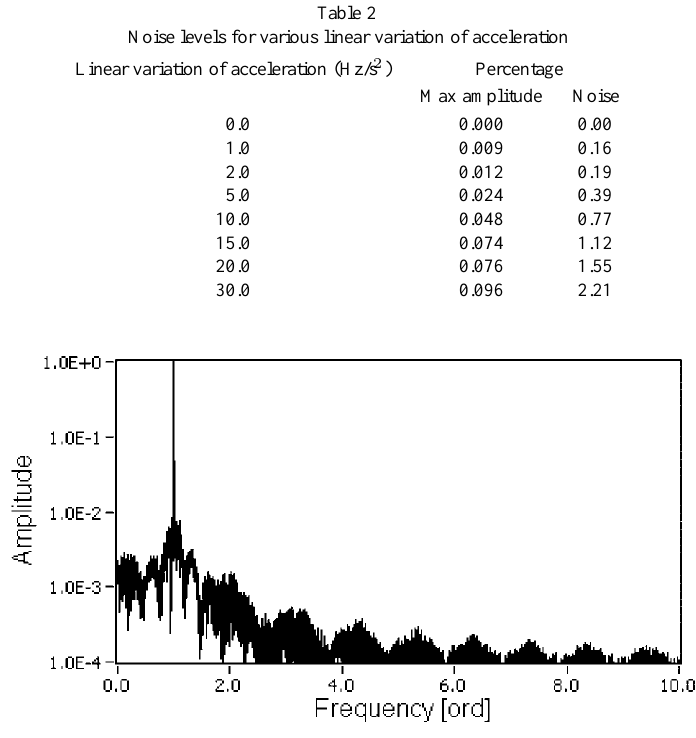
Table 2 Noise levels for various linear variation of acceleration